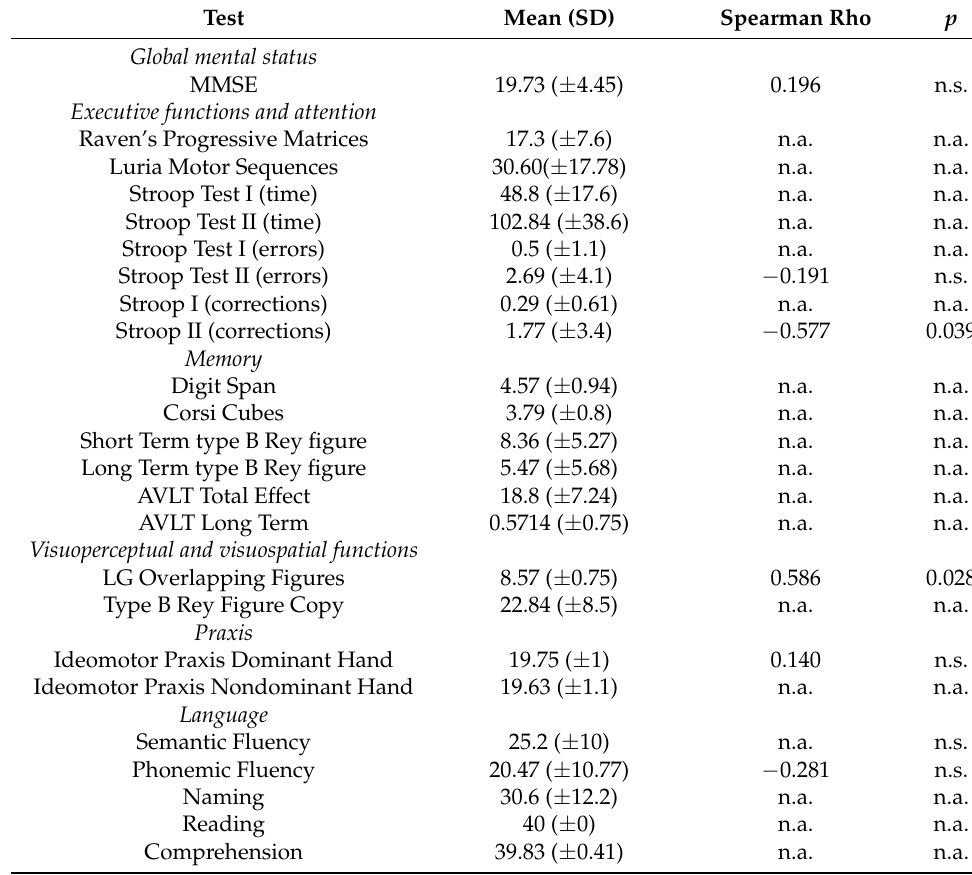
Table 3. Scores in general and domain-specific neuropsychological tests in the AD cohort. Relation- ship between CSF α -CGRP content and neuropsychological performance in selected domain-specific tests. Scoring is expressed as the mean and standard